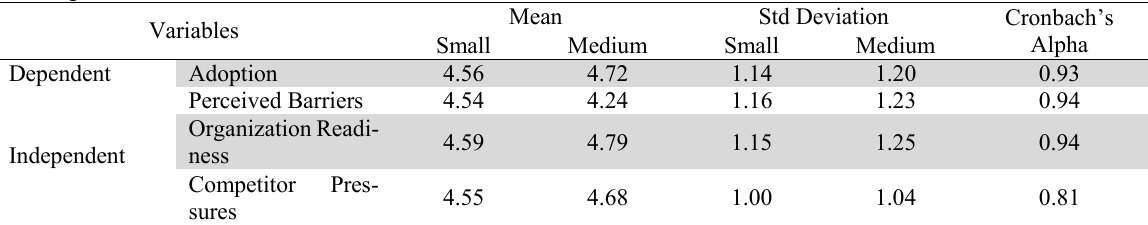
Descriptive Data